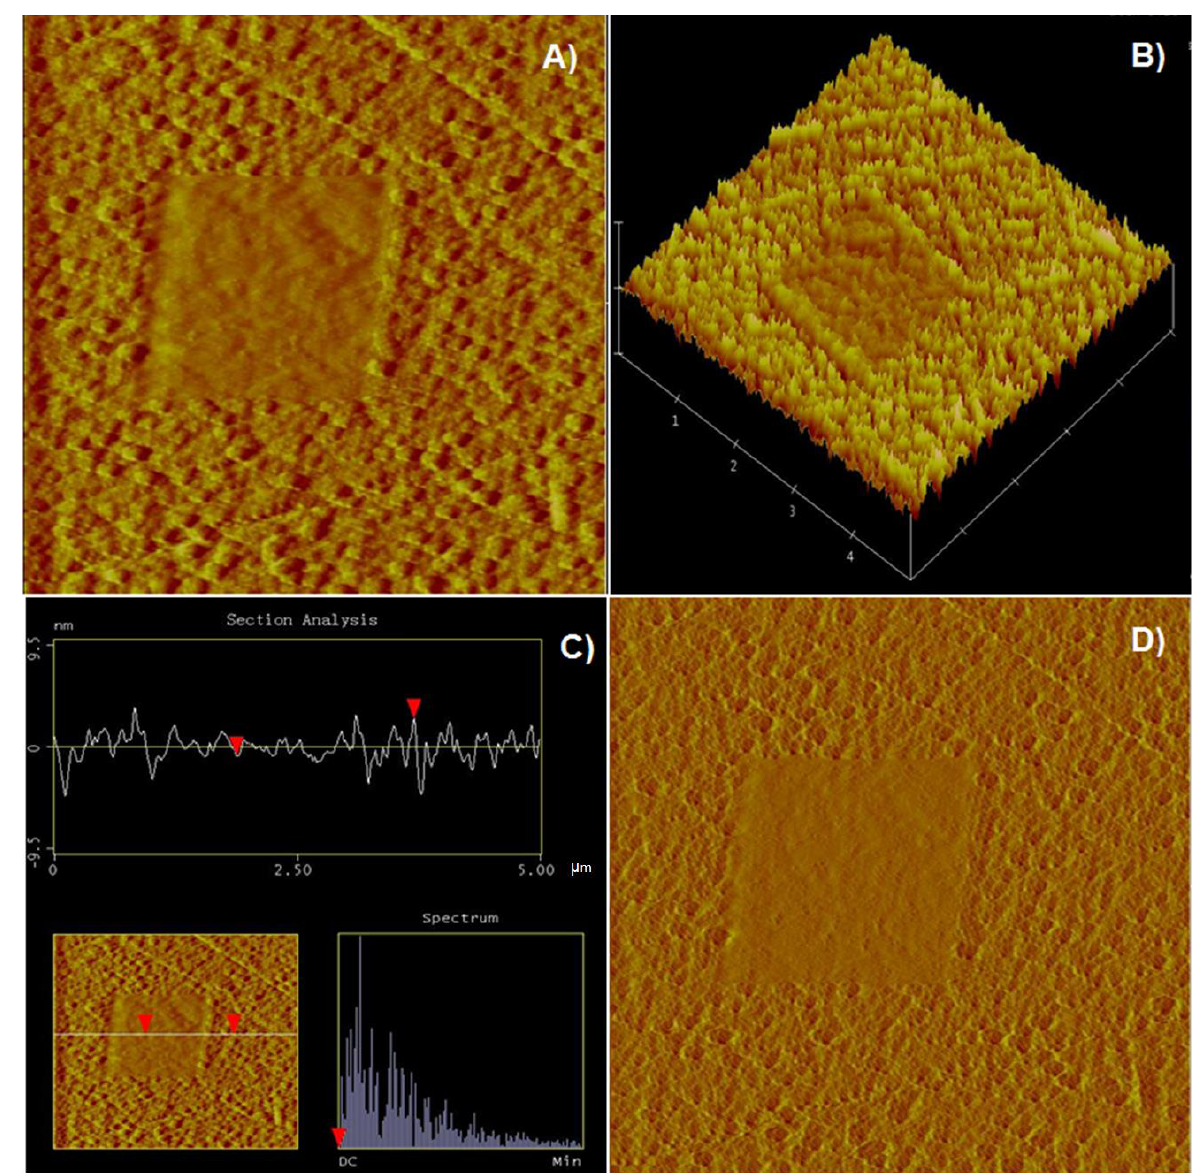
Figure 11. AFM images of a bornite surface soaked in 1 × 10 − 4 M PAX solution at pH 6 for 20 min. ( A ) The 5 µm × 5 µm height image with a data scale of 20 nm, ( B ) the 3D image, ( C ) the section analysis and ( D ) the deflection image with a data scale of 10 nm. The 2 µm × 2 µm blank ‘window’ in the center of the image occurred due to the removal of the adsorbate from the mineral surface under the intentionally applied large scan force.